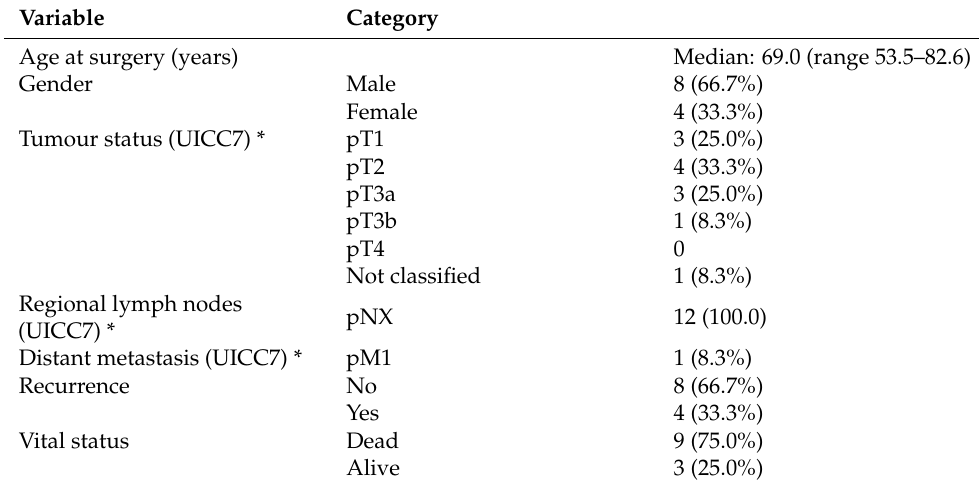
Table 1. Clinicopathological characteristics of the included HCC patients ( n = 12).